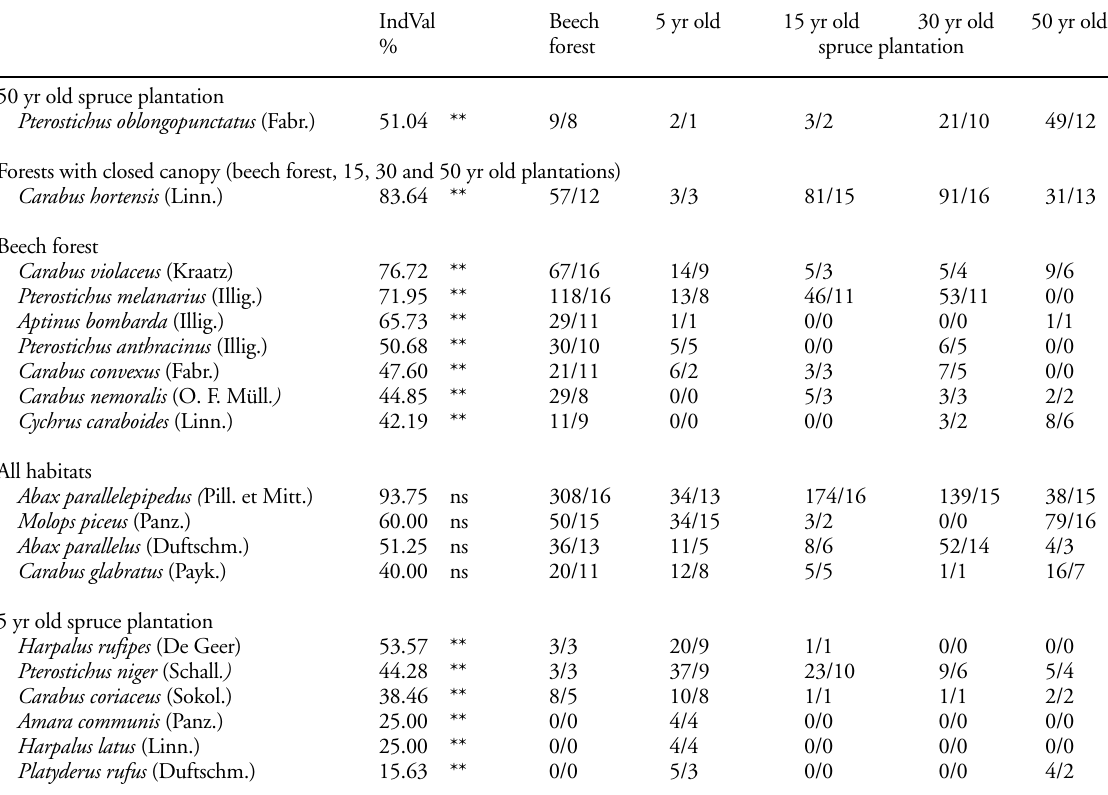
Table 1. Two-way indicator table for the species which were present at levels of five or more individuals. The IndVal% column is the species indicator value for the habitat. ** indicates a significant (p<0.01), while “ns” not significant IndVal result. Inside columns, the first number is the number of individuals present, and the second one is the number of traps where the species was present in the habitat.